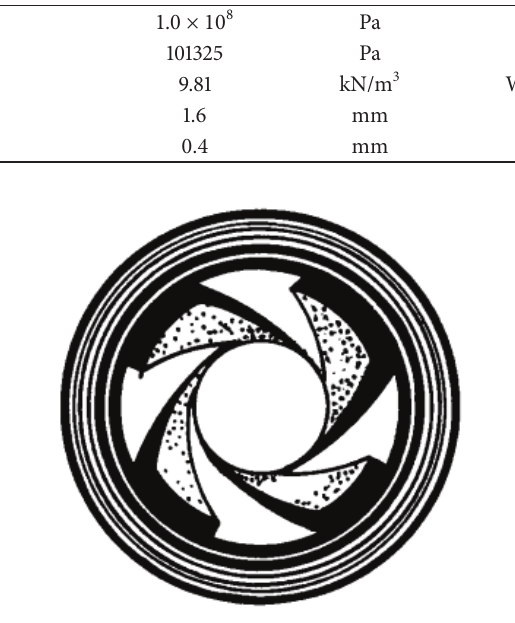
Figure 5: Gun barrel line structure.